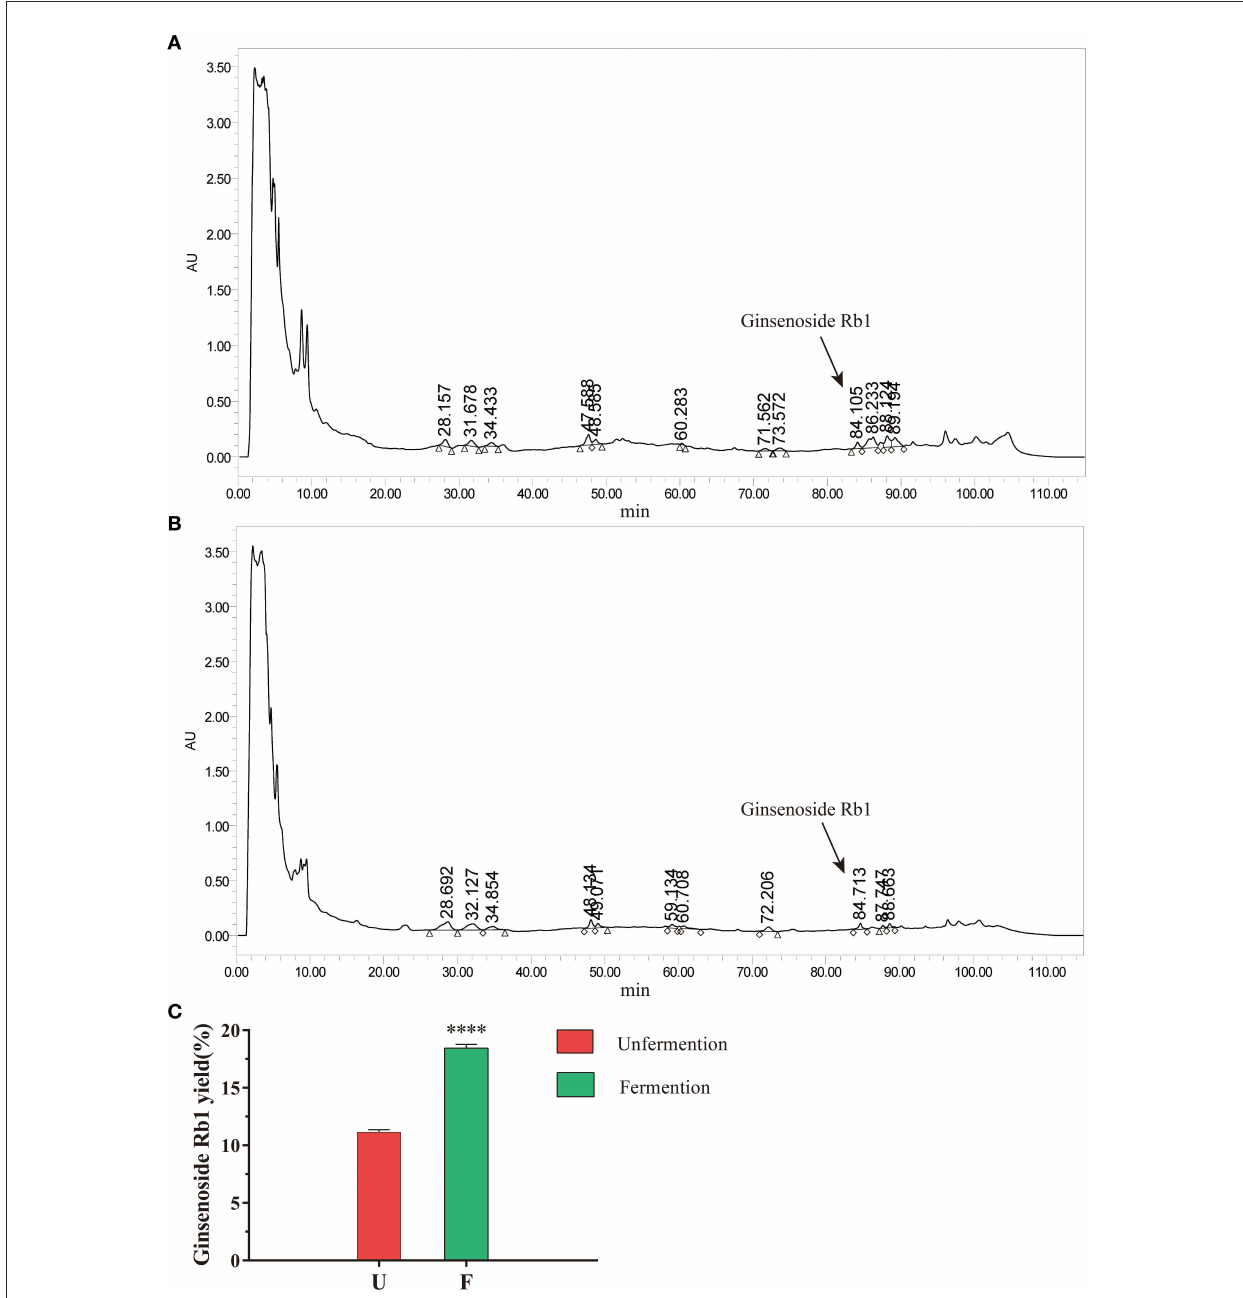
FIGURE1 Effects of L. plantarum fermentation on SLBZS. (A) Chromatograms of unfermented SLBZS. (B) Chromatogram of fermented SLBZS. (C) The yield of ginsenoside Rb1 before and after SLBZS fermentation. Bars represent mean values ± SD ( n = 3). **** indicate p < 0.0001 compared with the